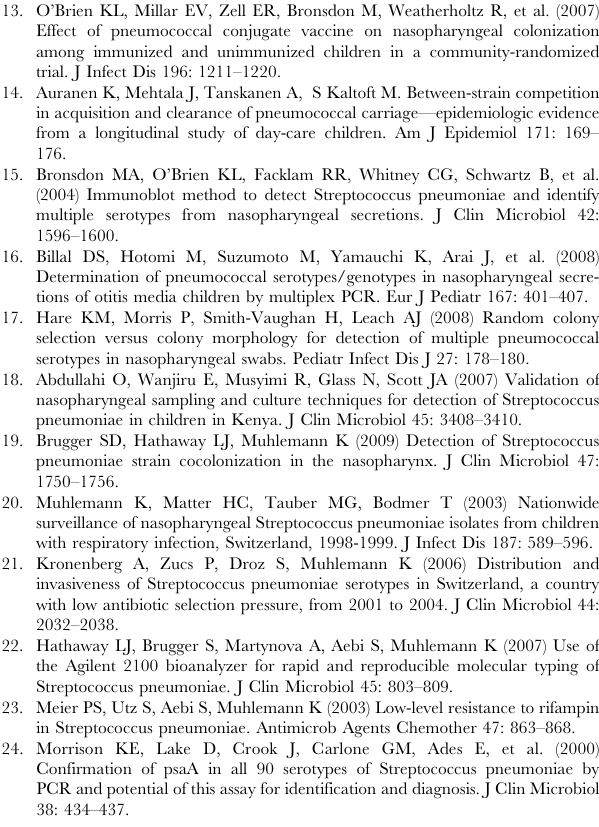
Multiple colonization by